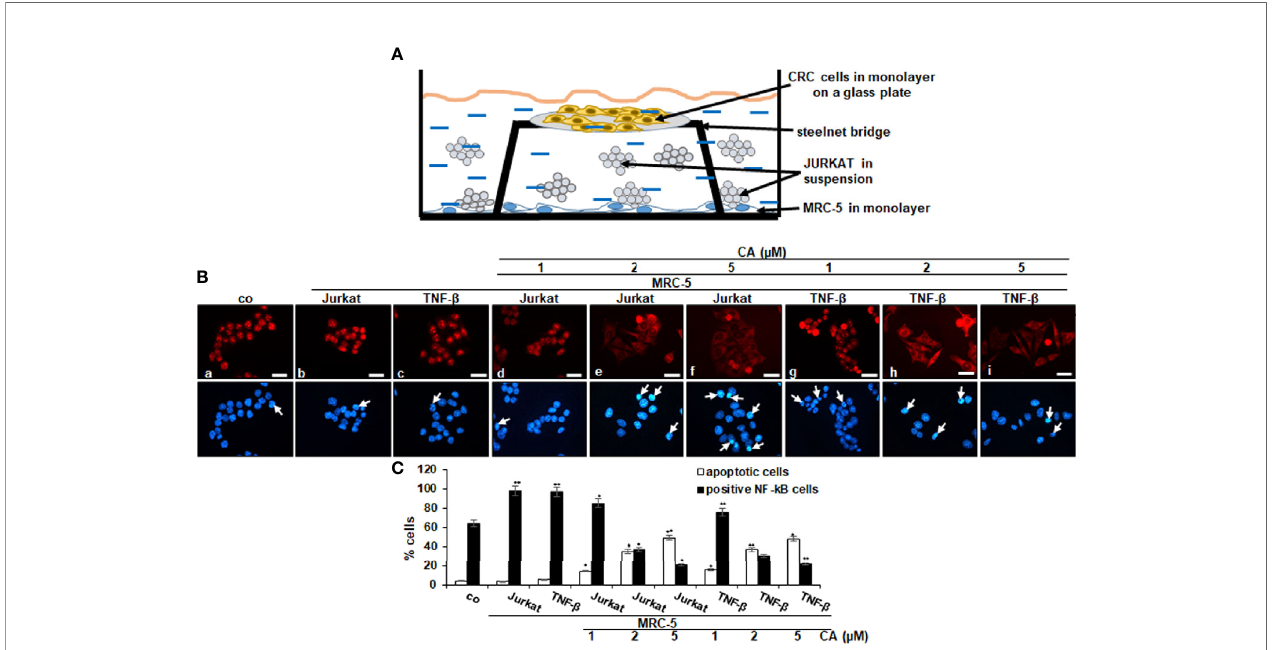
FIGURE 4 | Effect of Calebin A on multicellular proin fl ammatory TME-induced activation and nuclear translocation of p65-NF- k B in CRC cells. (A) Schematic representing the experiment model of the HCT116 cells in TME for immuno fl uorescence assay. (B) Serum-starved HCT116 cells in monolayer cultures alone (co) or co-cultured with fi broblasts and T-lymphocytes or co-cultured with fi broblasts and TNF- b (10 ng/ml) were either left untreated, or treated with various concentrations of Calebin A (CA) (1, 2, and 5 µM), as described in Materials and Methods . Magni fi cation 600×; scale bar = 30 mm. All experiments were performed at least in triplicate, and quanti fi cation of positively labeled p65-NF- k B-nuclei and apoptotic nuclei (white arrows) were performed by counting 400 – 500 cells from 20 different microscopic fi elds (C) . Values were compared with the control, and * p < 0.05 and ** p < 0.01 were considered statistically signi fi